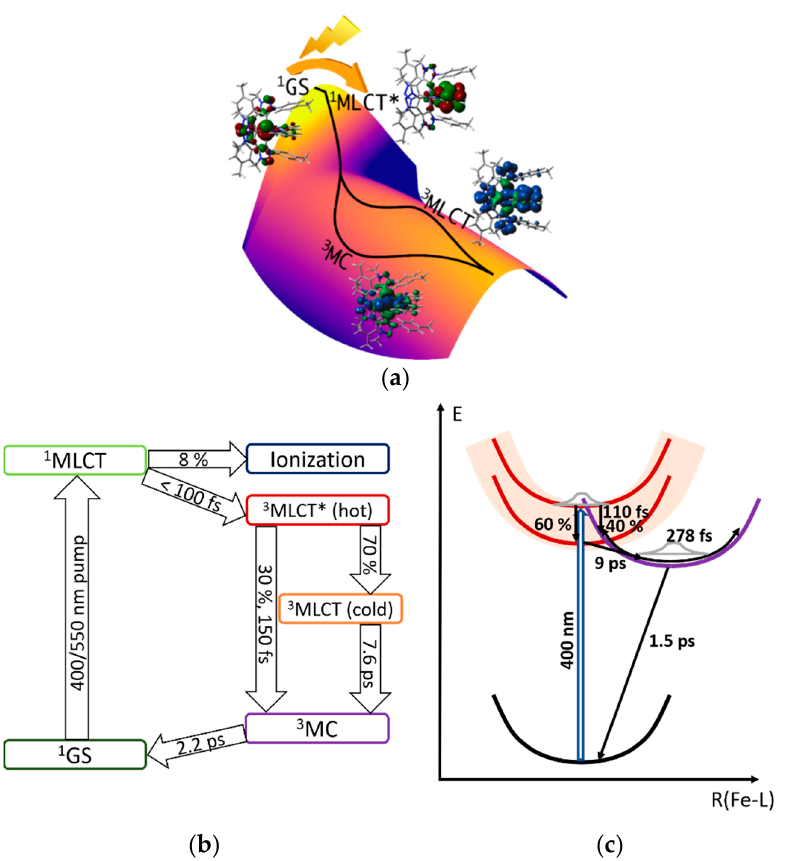
Figure 9. Schematic representations of advanced photoinduced dynamics probed using time-resolved X-ray spectroscopy. ( a ) Hot branching dynamics of complex 11 according to [67] displaying the evolution of the spectral shift of the measured TR-XES data over time together with associated electronic structure properties of the excitation process and branching states; ( b ) associated scheme summarizing the measured deactivation kinetics; ( c ) vibrational wave packet dynamics of complex 1 according to [68].